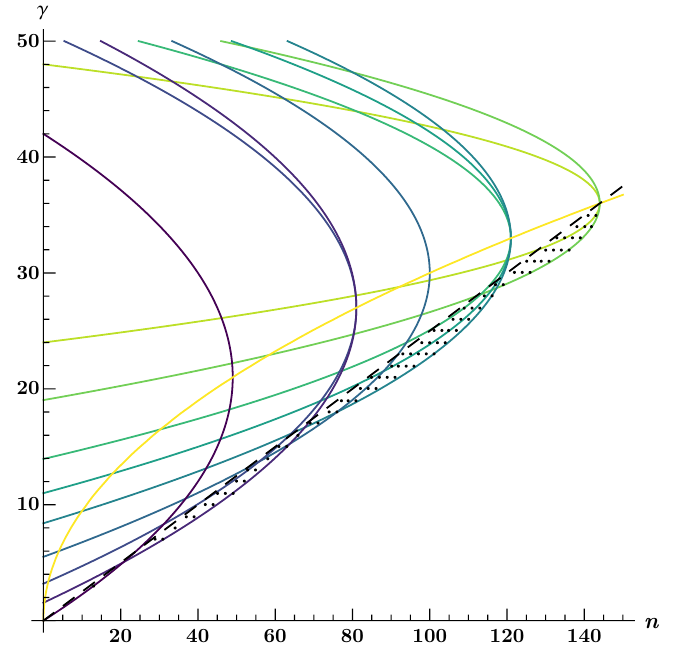
p Figure 4 . A plot of the parabolas n = b 2 (cid:0) ( (cid:13) (cid:0) 3 b 0 ) 2 with the critical value b 0 = b 6 + 2 9 (cid:0) T + 1 c , 0 T for T = 1 ; : : : ; 9. These values are b 0 = 12 ; 12 ; 11 ; 11 ; 11 ; 10 ; 9 ; 9 ; 7 for T = 1 ; : : : ; 9, respectively. The lightest yellow curve is the parabola n = (cid:13) 2 = 9, relevant for T = 0, and the curves for T = 1 ; : : : ; 9 appear in progressively darker colors. The dashed line is n = 4 (cid:13) , the line below which there exist valid choices of anomaly coe(cid:14)cient that do not yield generic matter solutions. In black are points within the parabolas for T = 1 ; : : : ; 9 for which there are valid solutions of the AC conditions but no solutions with generic